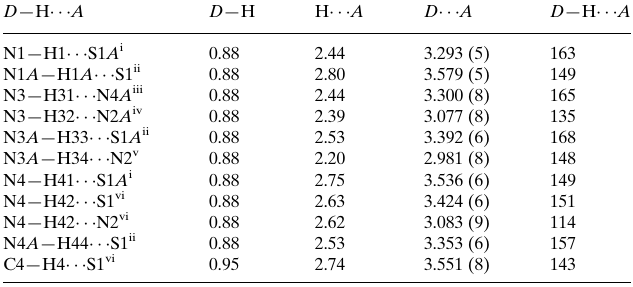
Hydrogen-bond geometry (A˚ , (cid:5)